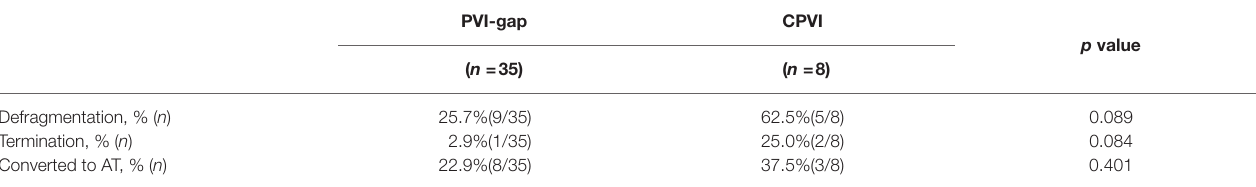
TABLE 2 | Flecainide-induced defragmentation rates of ongoing AF after the CPVI vs. PVI-gap.